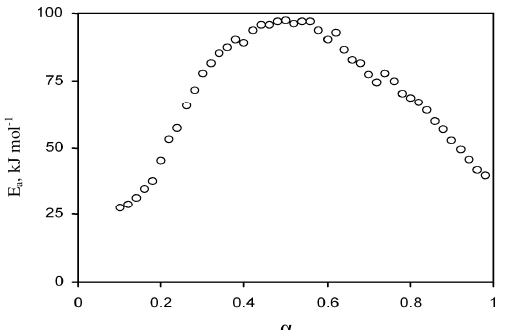
Figure 4. Variation of E method